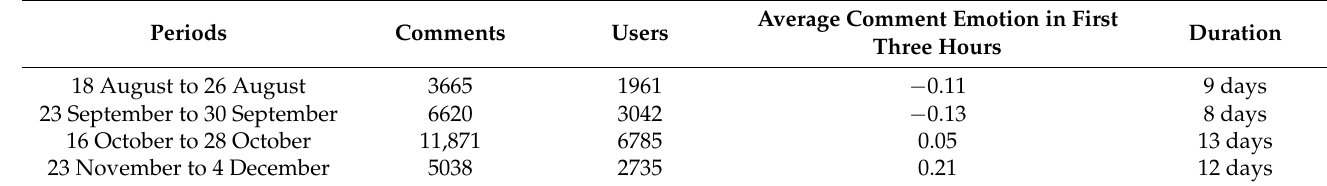
Table 5. Comments